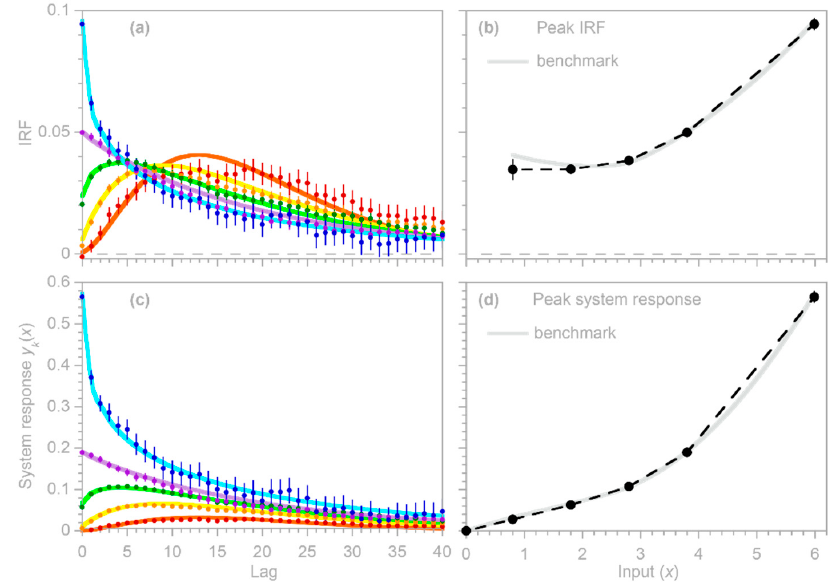
Figure 13. Nonlinear deconvolution of a benchmark impulse response that changes its shape as a function of the input. Benchmarks (lines) and estimated impulse responses (dots) are shown for a test in which the gamma ‐ distributed benchmark impulse response function’s shape factor 𝛼 de ‐ creases from roughly 3 at the lowest knot (corresponding to the red curve and dots) to approxi ‐ mately 0.7 at the highest knot (corresponding to the blue curve and dots). The impulse response functions (system response per unit input) and the system responses themselves, along with their benchmarks ( a , c ), are evaluated at the knots 𝑥 (cid:3404) 𝜅 ℓ (in this case, at values of 0.8, 1.8, 2.8, 3.8, and 6, the highest value of the input 𝑥 ), indicated by the colors red, orange, green, purple, and blue, re ‐ spectively. The corresponding peak values of the impulse response function and system response are shown in panels ( b ) and ( d ). Error bars show 1 standard error, wherever this is larger than the plotting symbols. 5.3. Biases in the Apparent Average Impulse Response of Nonlinear Systems Conventional methods for estimating impulse response functions are based on the premise that the underlying system exhibits linearity and stationarity, that is, that the function 𝛽(cid:4666)𝜏(cid:4667) in Equation (1) and the coefficients 𝛽 (cid:3038) in Equation (3) depend only on the lag time 𝜏 or the lag index 𝑘 , and are otherwise constant (i.e., stationary), and in particu ‐ lar are independent of the input 𝑥 (i.e., linear). What if the real ‐ world system is not linear and stationary, but nevertheless is analyzed as if it were? The benchmark tests in Section 4.3 above examined what would happen if time series from nonstationary (but linear) sys ‐ tems were analyzed as if those systems were stationary instead. The results showed that such cases can be expected to yield estimates (dots in Figures 6b and 7e) that approximate the average of the actual, nonstationary impulse response (lines in Figures 6b and 7e). This is generally true for nonlinear systems. Insight into the reasons why can be gained from a simple theoretical analysis. Consider the following relationship, 𝑦 (cid:3037) (cid:3404) 𝛽 (cid:3037) 𝑥 (cid:3037) (cid:3397) 𝛼 (cid:3397) 𝜀 (cid:3037) , (48) which can be viewed as an analogue to Equation (3) in which the lags k are ignored (a simplification) and the constant 𝛽 has been replaced by the time ‐ varying 𝛽 (cid:3037) (a compli ‐ cation). Because 𝛽 (cid:3037) is not constant, and potentially could be different for every time step 𝑗 , Equation (48) is not a regression equation. However, what if we did not know that?